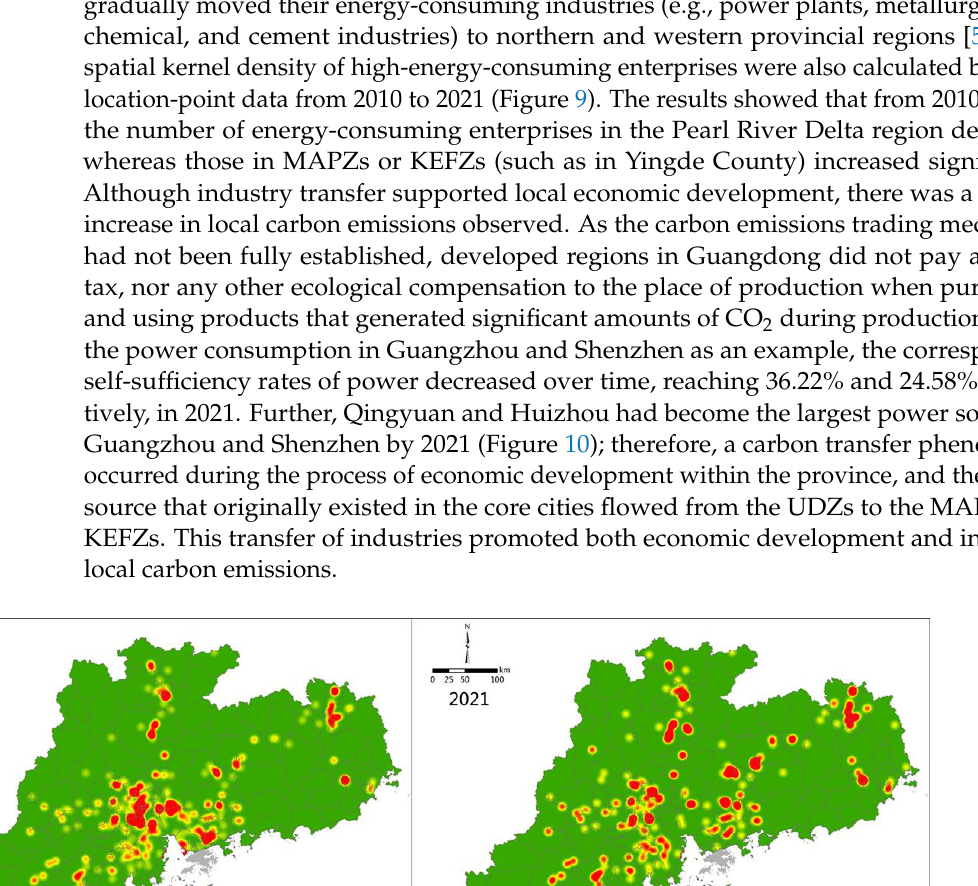
Figure 10. Power transfer of Guangdong Province in 2021. The migration characteristics of the GDP and carbon emissions gravity centers in UDZs were similar to those of Guangdong Province. The GDP centers continued to move to the southeast (toward Shenzhen), with an average annual movement rate of ~1 km·yr −1 , illustrating the existence of differences in economic development within the UDZs. Here,